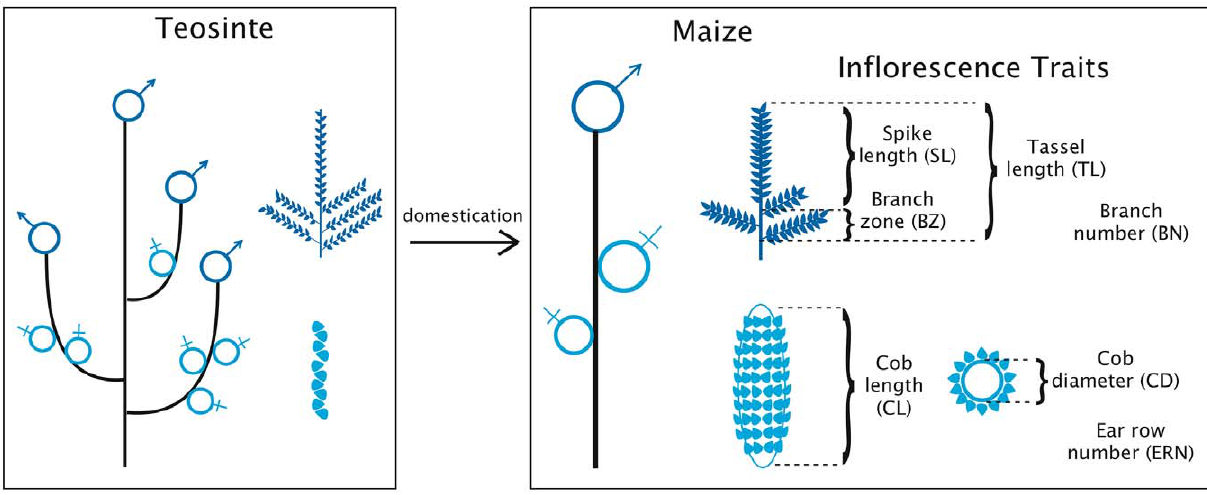
Figure 1. Evolution of plant and inflorescence architecture during maize domestication. Male inflorescences are depicted in dark blue, and female inflorescences in light blue. The seven inflorescence traits measured in this study are also depicted. Note the change in placement of the female inflorescence during maize domestication: it occupies multiple lateral positions on the primary lateral branch of teosinte, and occupies a single, apical position on the primary lateral branch of maize.